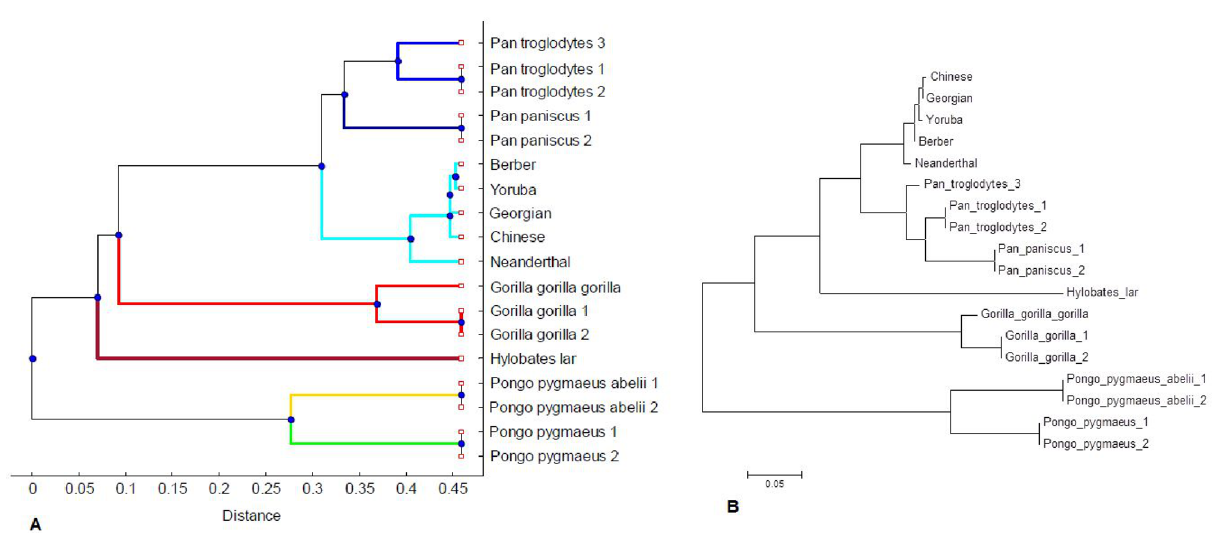
Figure 7. The mtDNA phylogenetic tree using 18 primate species sequences(test sequences). ( A ) Phylogenetic tree is constructed with our algorithm (Alignment Free method). The similar sequences are grouped into cluster. Clusters are shown with different colours. ( B ) Phylogenetic tree using clustalW (Alignment based